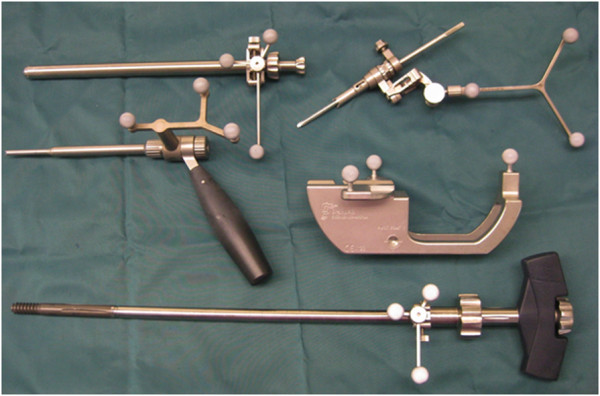
Instruments for the navigation-assisted operation.